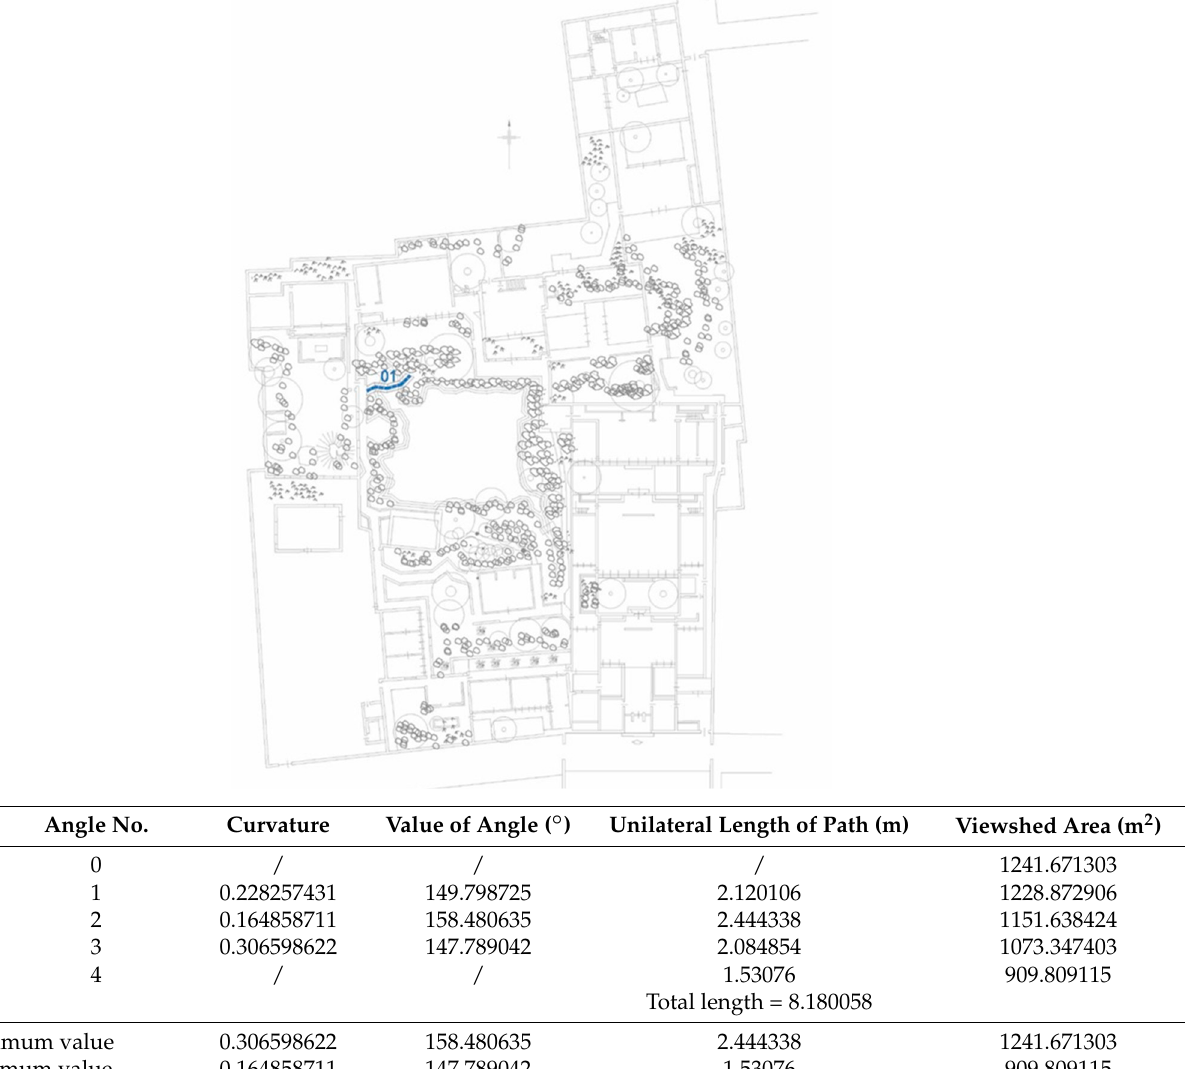
Table A23. Master of the Nets Garden, bridge.